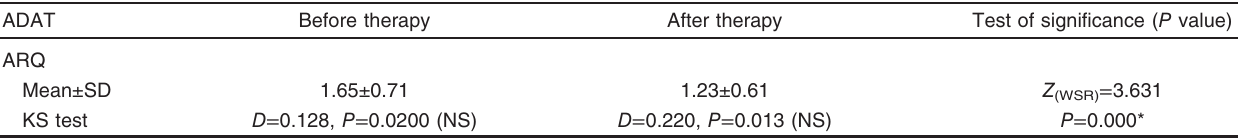
Table 5 Comparison between the studied group before therapy and after therapy regarding Arabic dyslexia assessment test